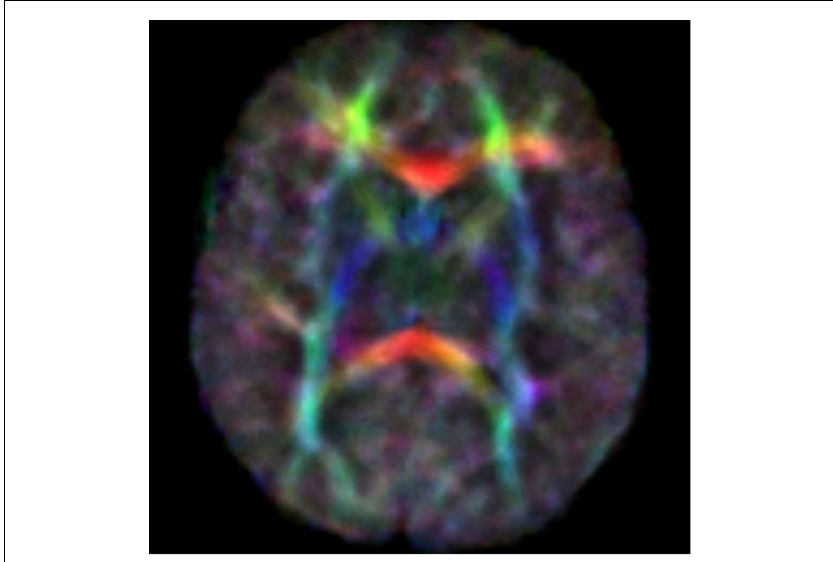
FIGURE 1 | Color anisotropy maps